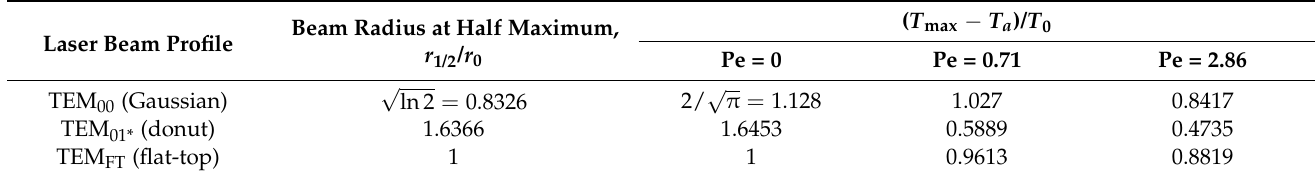
Table 1. Calculated absolute maximum of temperature T max versus P é clet’s number Pe.